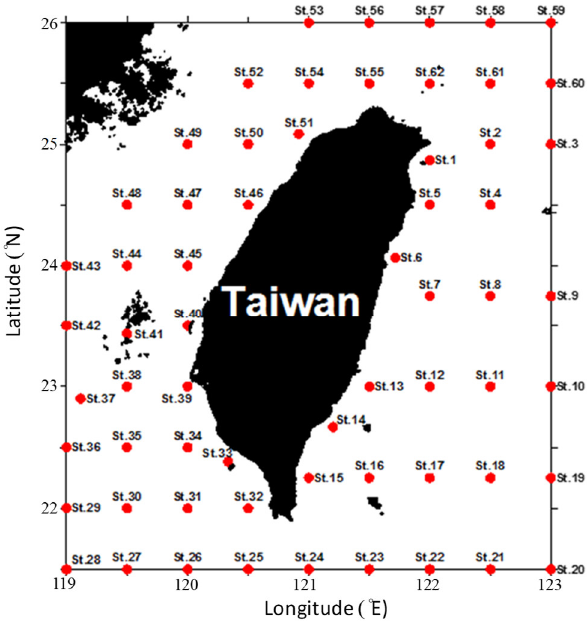
Figure 1. Sixty-two sampling locations of Fisheries Research I cruises around the waters of Taiwan between 21.5°–26°N and 119°–123°E. Table 1. Cruise numbers, data, season, and number of PP measurement stations of Fisheries Research I from 2009 to 2013. Cruise